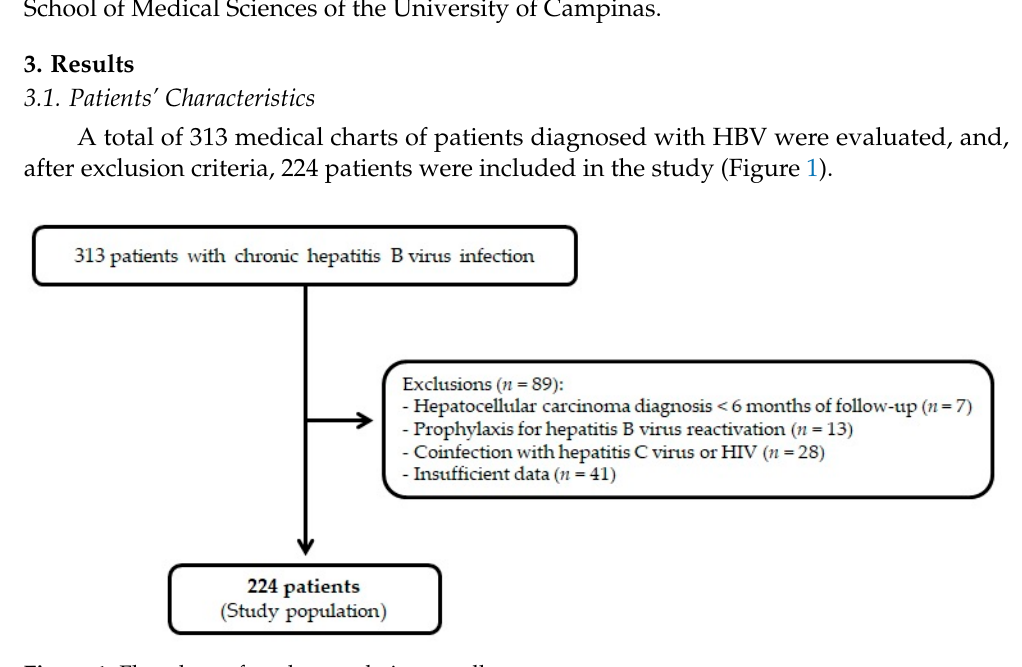
Table 1. Population characteristics ( n = 224).